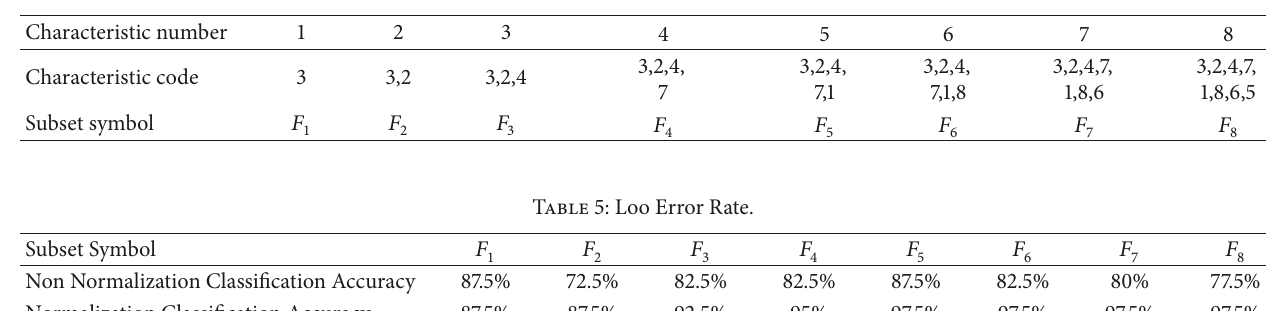
Table 4: Nested feature subset.